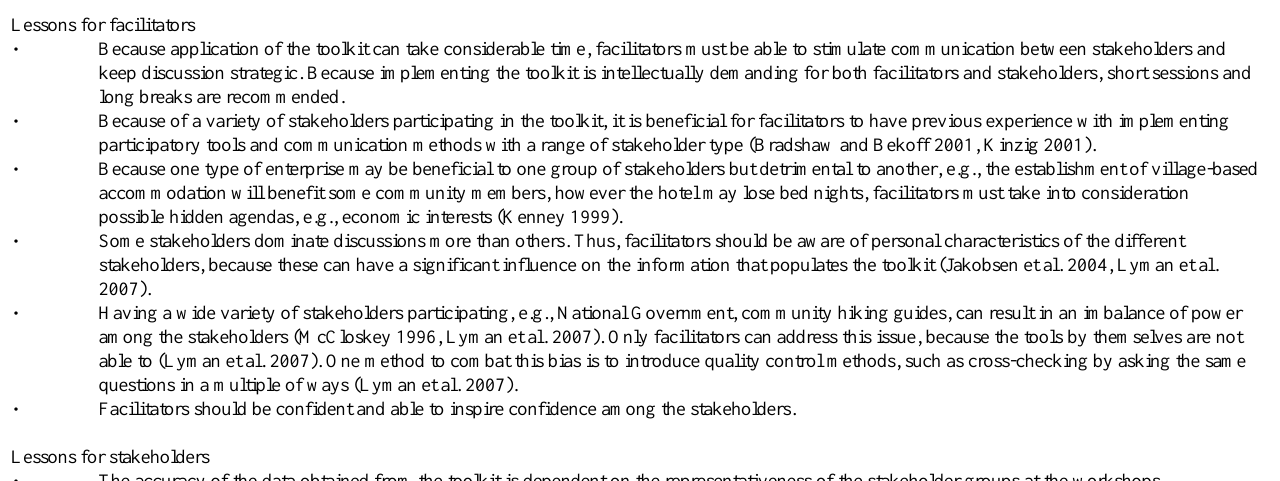
Table 6 . Participatory lessons learned from applying the